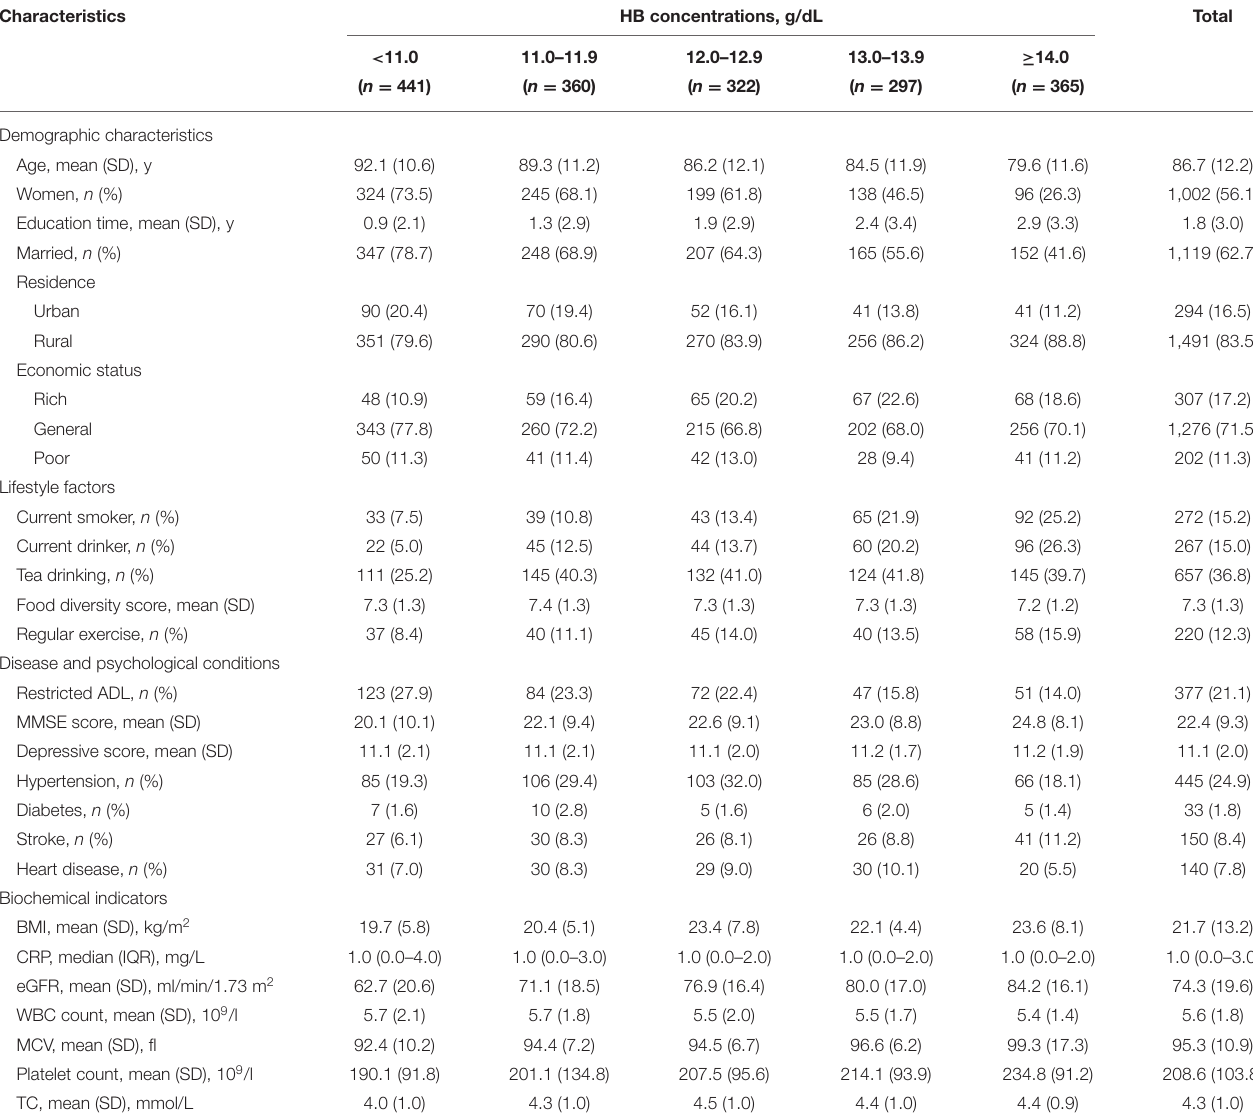
TABLE 1 | Baseline characteristics of respondents according to HB concentrations.